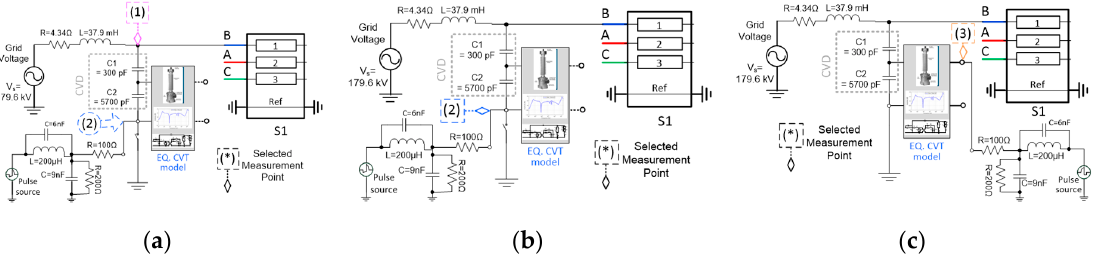
Figure 12. Details of the three injection/measurement scenarios under study: ( a ) Scenario #1, ( b ) Scenario #2, and ( c ) Scenario #3.